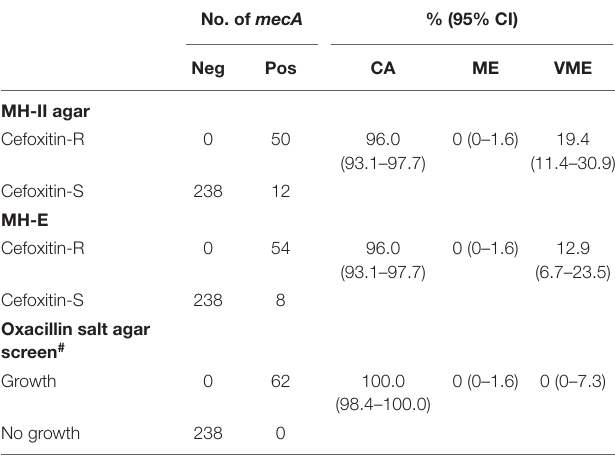
TABLE 1 | Performance of cefoxitin DD and oxacillin agar screen for detecting of mecA -mediated oxacillin resistance in S. lugdunensis . No. of